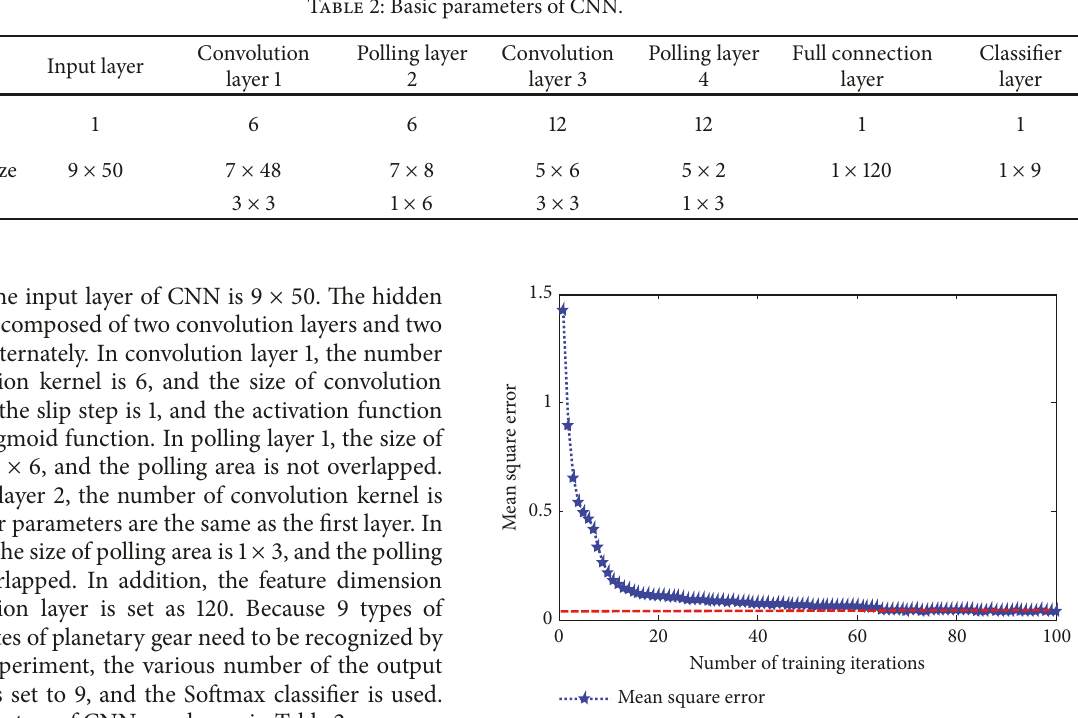
Figure 8: The training process of